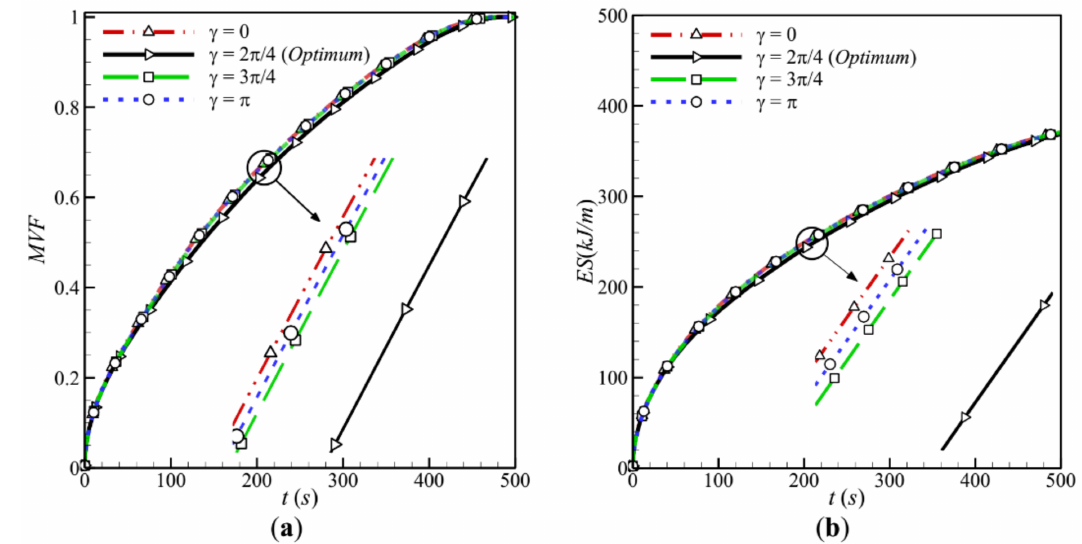
Figure 13. The effect of various inclination angles of the enclosed medium: ( a ) on the melting volume fraction and ( b ) energy stored when VF na = 0.01, ε = 0.800, a = − 2, and PPI =